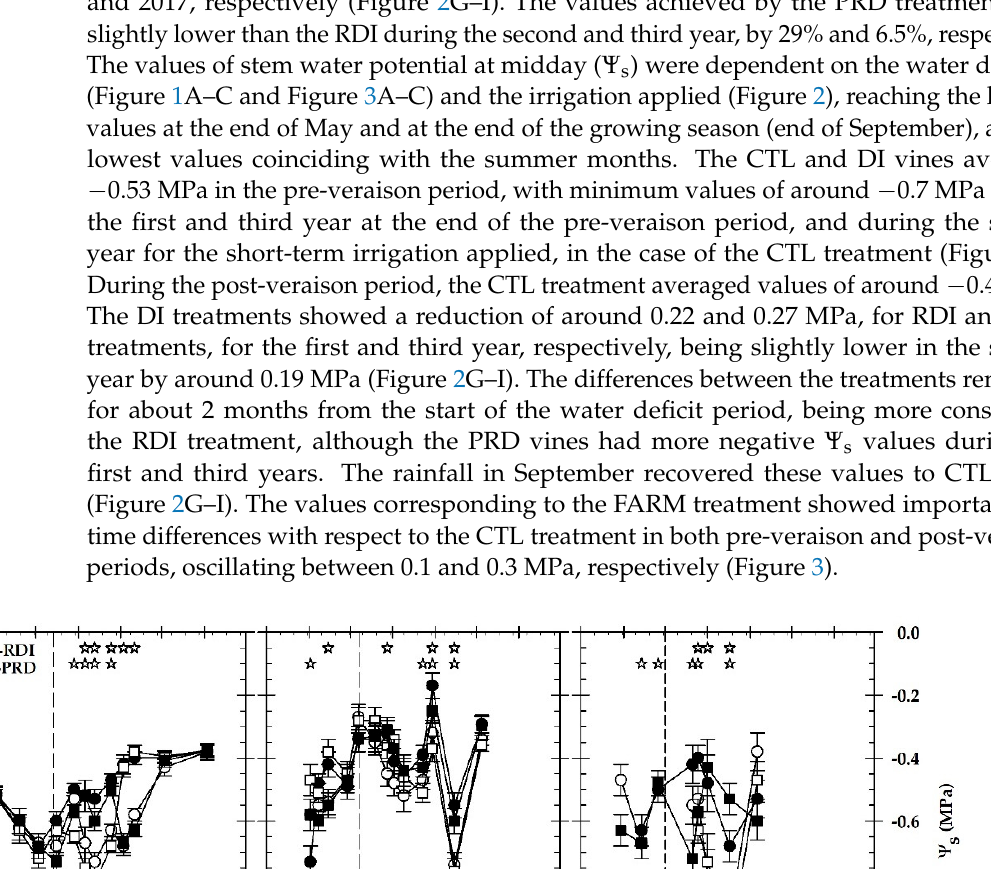
(white inverted triangles) during the three years assayed (2015–2017). The vertical dash line indicates the start of the post- veraison period.